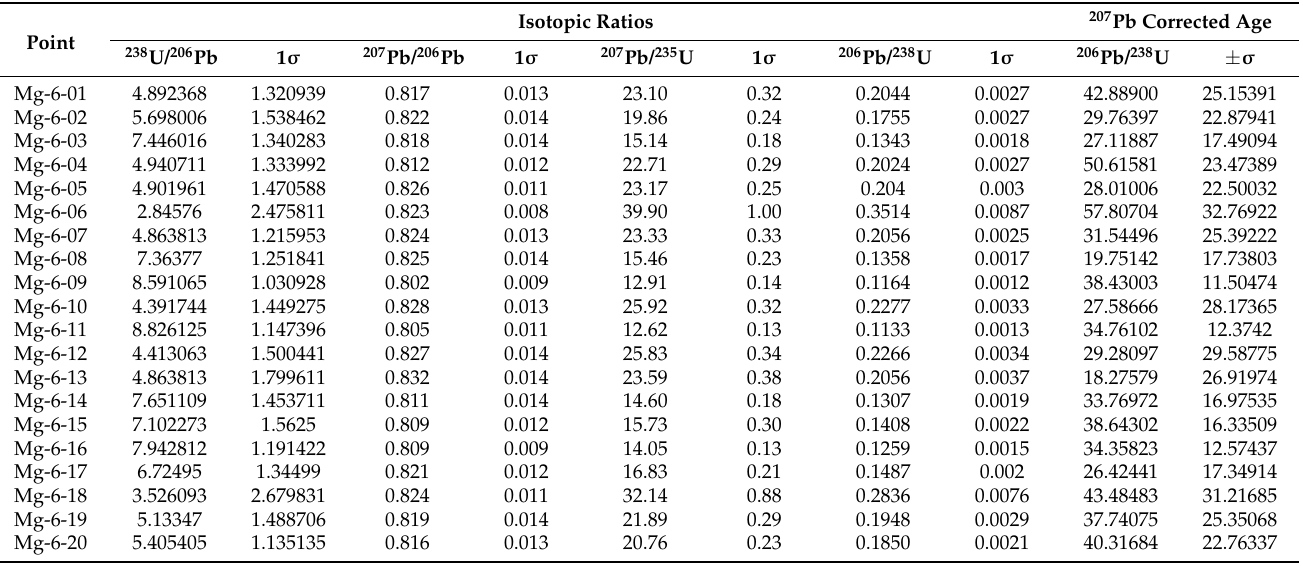
Table 5. U–Pb dating data of